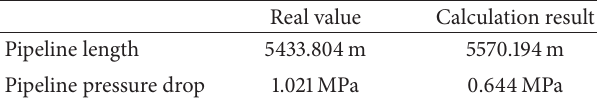
Table 4: Calculation